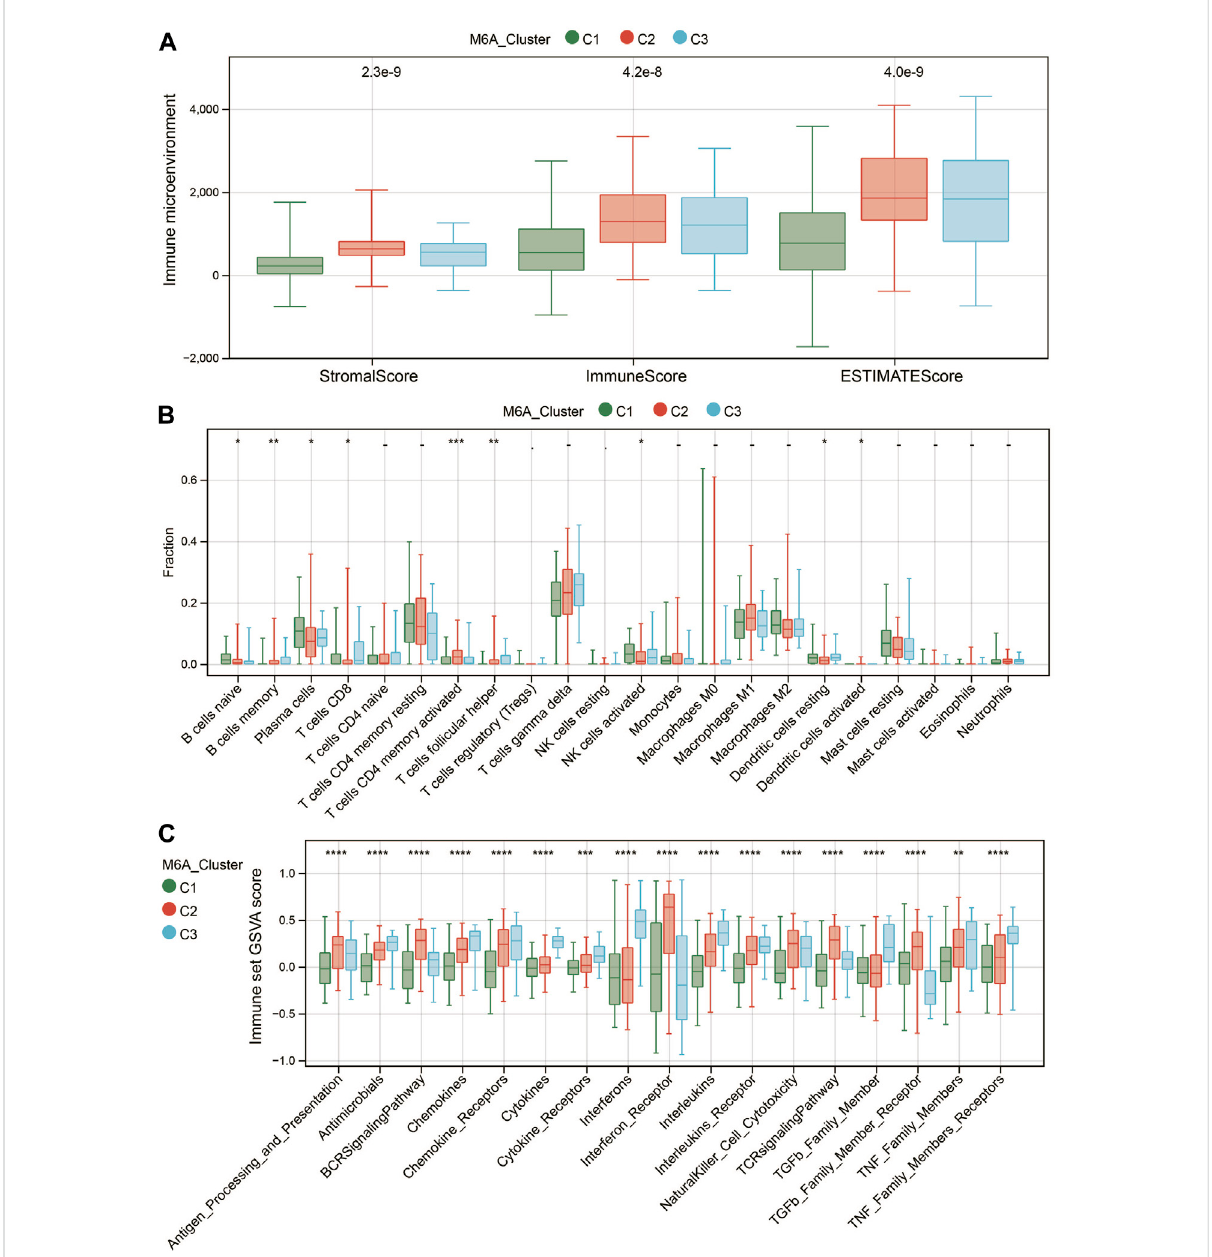
FIGURE 4 Characteristics of the immune microenvironment indifferent m6A modi fi cation patterns. (A) Differences in TME scores among the three m6A- modi fi edsubtypes. (B) Differencesintheabundanceof22immunecellsamongthethreem6Amodi fi cationpatterns. (C)